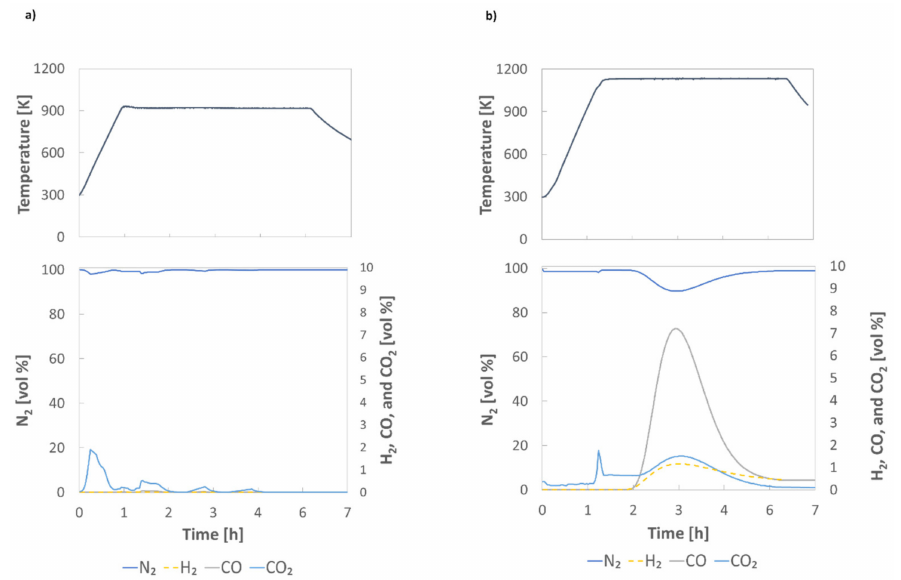
Figure 3. Test in N 2 at ( a ) 973 K and ( b ) 1173 K. Temperature profile inside the reactor and gas composition at the outlet (N 2 , H 2 , CO, and CO 2 volumetric